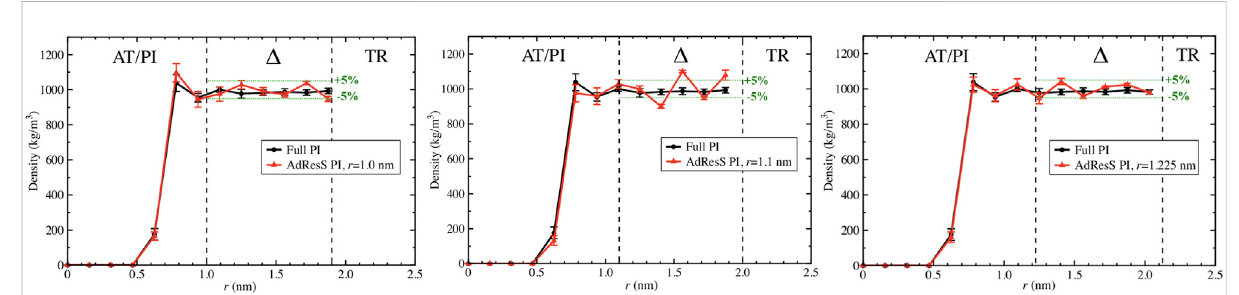
FIGURE 3 Particle number density calculated in the AdResS setup and compared to the density calculated in the reference simulations for three different radiiofthePIregion,namely, r =1 nm , r =1.1 nm, and r =1.22 nm .Allthree fi guresshowsuf fi cientagreementwiththereferencedensity.For r =1 nm , despiteasatisfactoryagreementinthe Δ region,theAdResSdensityclosetothefullereneshowsaslightdisagreementwiththereferencedensity.For r = 1.1 nm in the Δ region, the accuracy of the density with respect to the density of reference is slightly beyond the 5% threshold. r = 1.22 nm shows satisfactory agreementover thewhole rangeand theaccuracyofthedensity inthe Δ region iswithin 5%comparedtothereference value.5% is usually considered a satisfactory threshold.